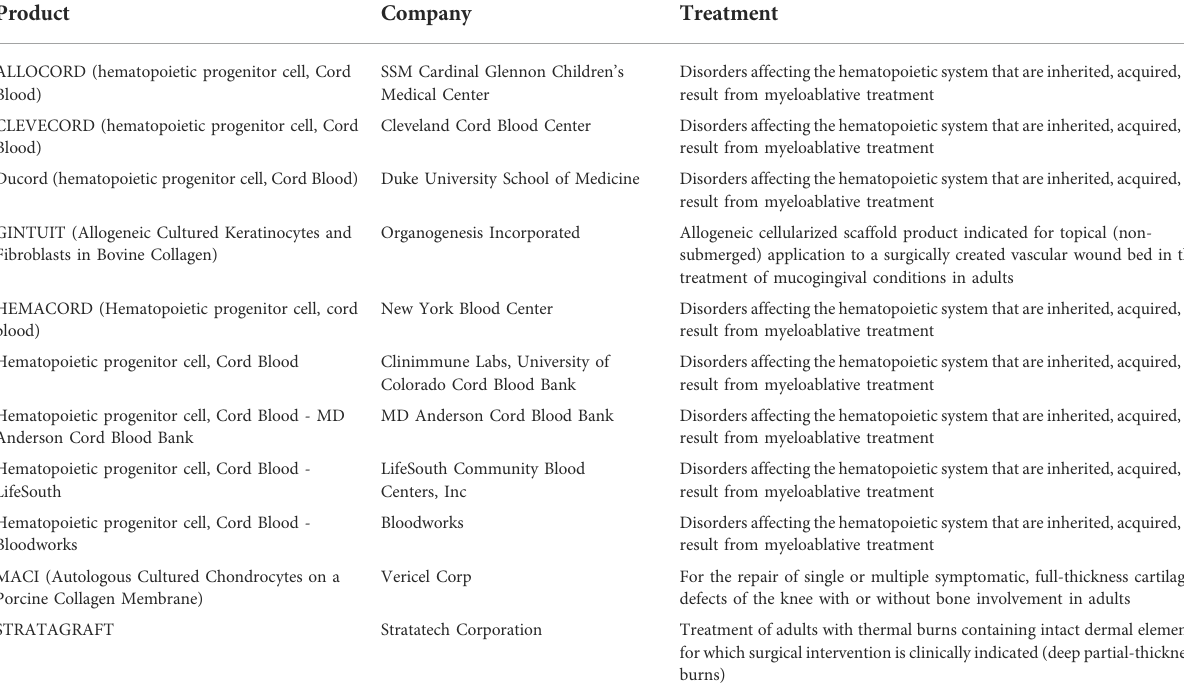
TABLE 1Alistof cellular andtissueengineered products with theproposed treatmentscurrentlyFDA approved. Allof theapproved cellular products are hematopoietic progenitor cell derived from Cord Blood approved for disorders affecting the hematopoietic system. The tissue engineered scaffolds are allowed for the treatment of mucogingival conditions, cartilage defects of the knee, and thermal burns.